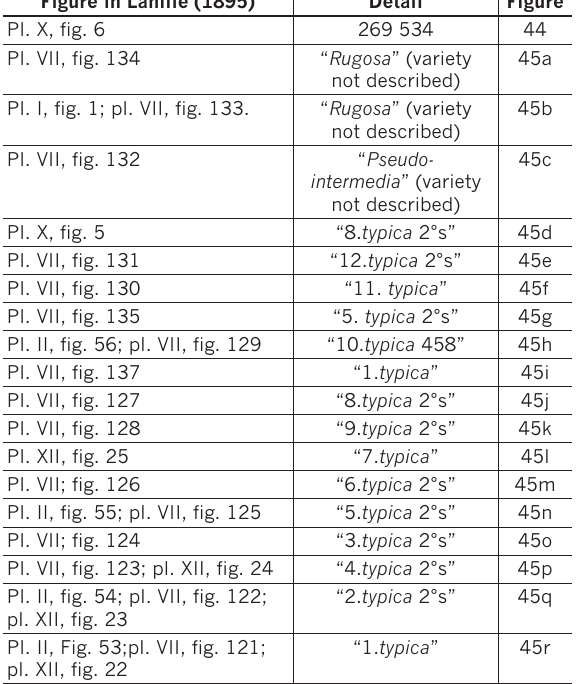
Table 17. Specimens of Voluta oviformis typica figured by La - hille (1895) with the detail of the inscriptions on their shells and figures here.